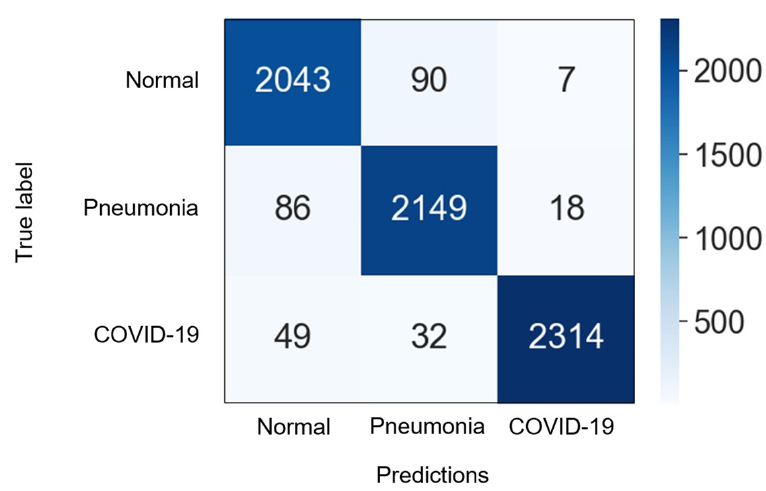
Figure 12. ROC curve for the VGG19 model on the test dataset.